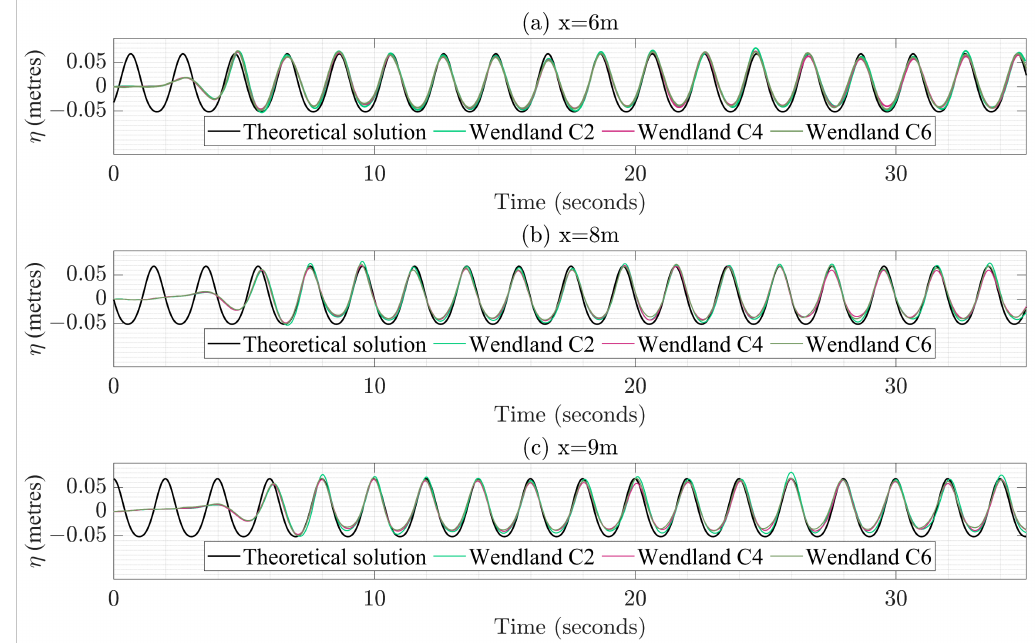
Figure 17. Comparisons of the wave surface elevations for the different kernel functions at three of the wave probe locations used in the numerical